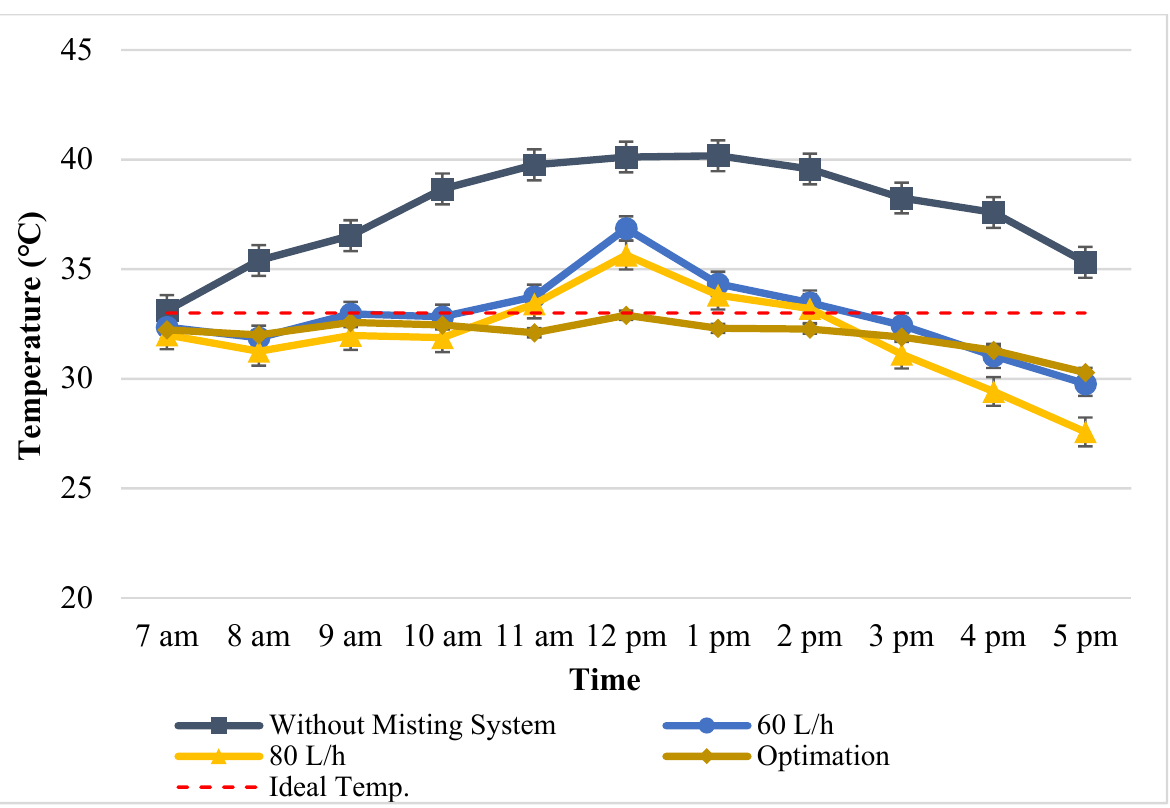
Figure 7. Temperature in the greenhouse using the optimum flow rate of water misting. Table 9. Humidity in the greenhouse using the optimum flow rate of water misting. Humidity Time